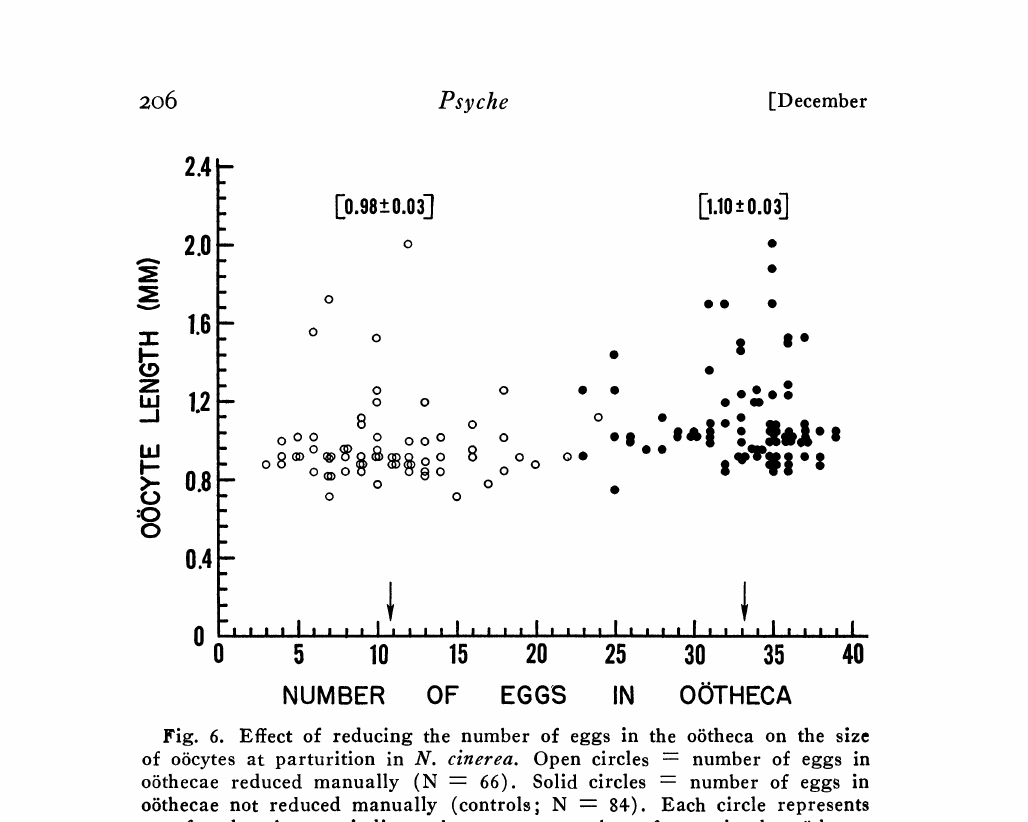
lrig. 6. Effect of reducing the number ot eggs in the oStheca on the size of o6cytes at parturition in N. cinerea. Open circles number of eggs in o6thecae reduced manually (N 66). Solid circles number of eggs in o6thecae not reduced manually (controls; N 84). Each circle represents one female. Arrows indicate the average number of eggs in the o6thecae for the 2 groups of females. Numbers in brackets are the mean lengths tandard errors of the o6cytes for both groups. O6cytes were measured <24 hr. after parturiti, on. Gestation period or the females whose o6thecae were artificially reduced in size averaged 60 days and for the control group 58 days. (Room